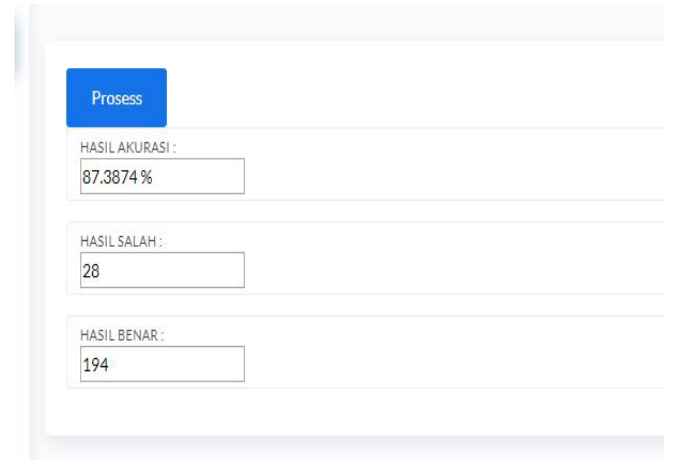
Fig. 15. Prototype Accuracy